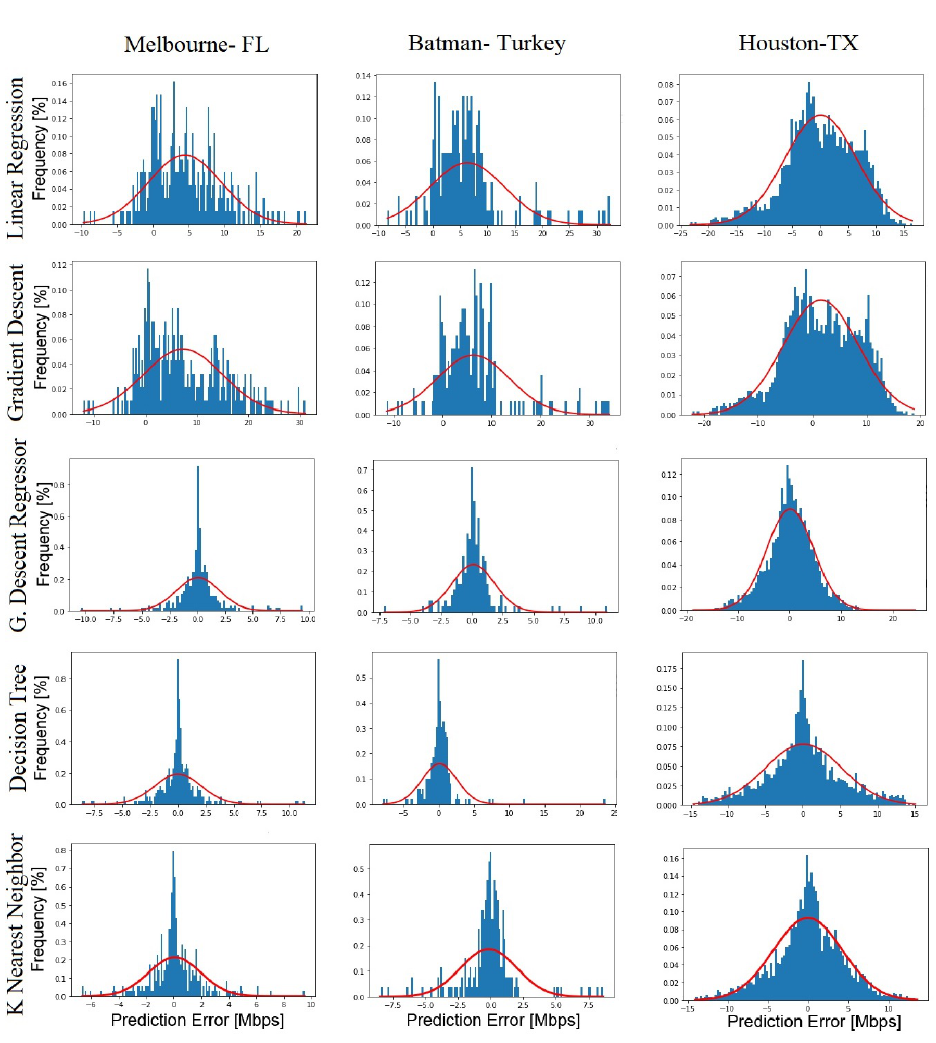
Figure 10. Prediction Algorithm Comparison.